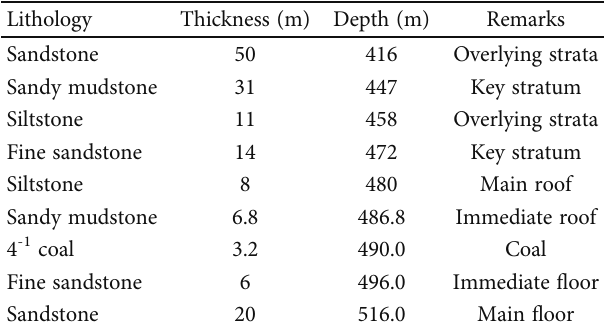
Table 1: Lithology of the study